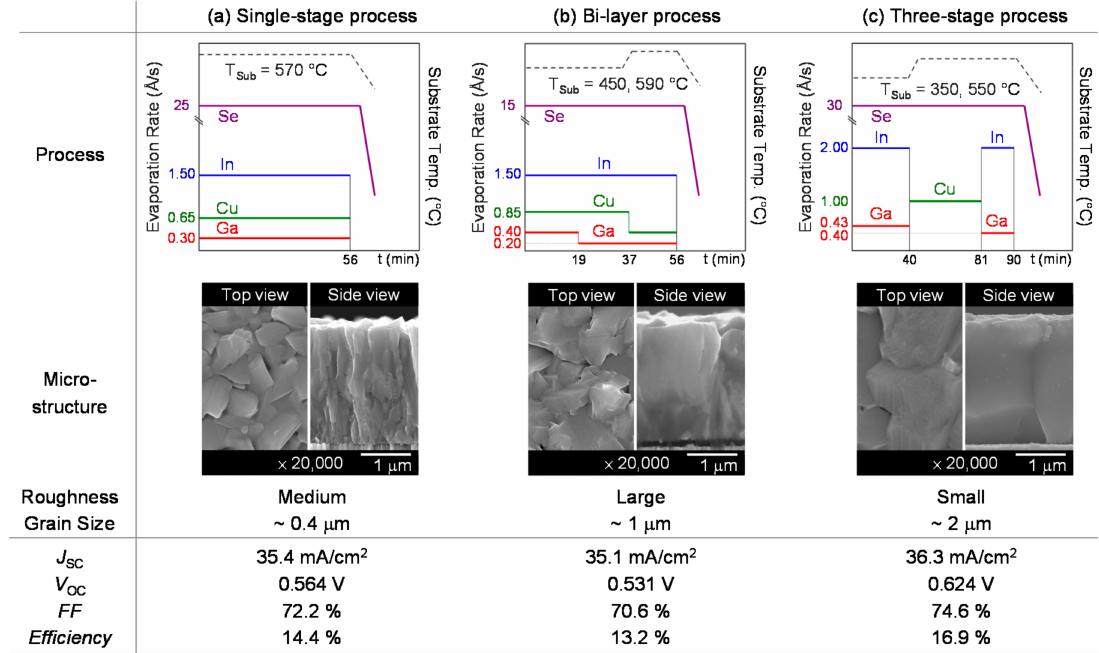
Figure 6. ( a ) Graphic presentation of single-stage process parameters, SEM micrographs of surface morphologies, and cross-sectional views of CIGS films prepared by single-stage process, and performance parameters, ( b ) Graphic presentation of bi-layer process parameters, SEM micrographs of surface morphologies, and cross-sectional views of CIGS films prepared by the bi-layer process, and performance parameters, and ( c ) Graphic presentation of three-stage process parameters, SEM micrographs of surface morphologies, and cross-sectional views of CIGS films prepared by the three-stage process, and performance